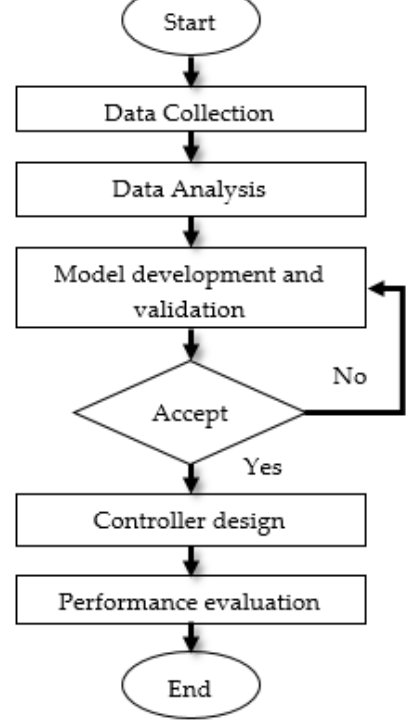
Figure 1. Workflow of the method.